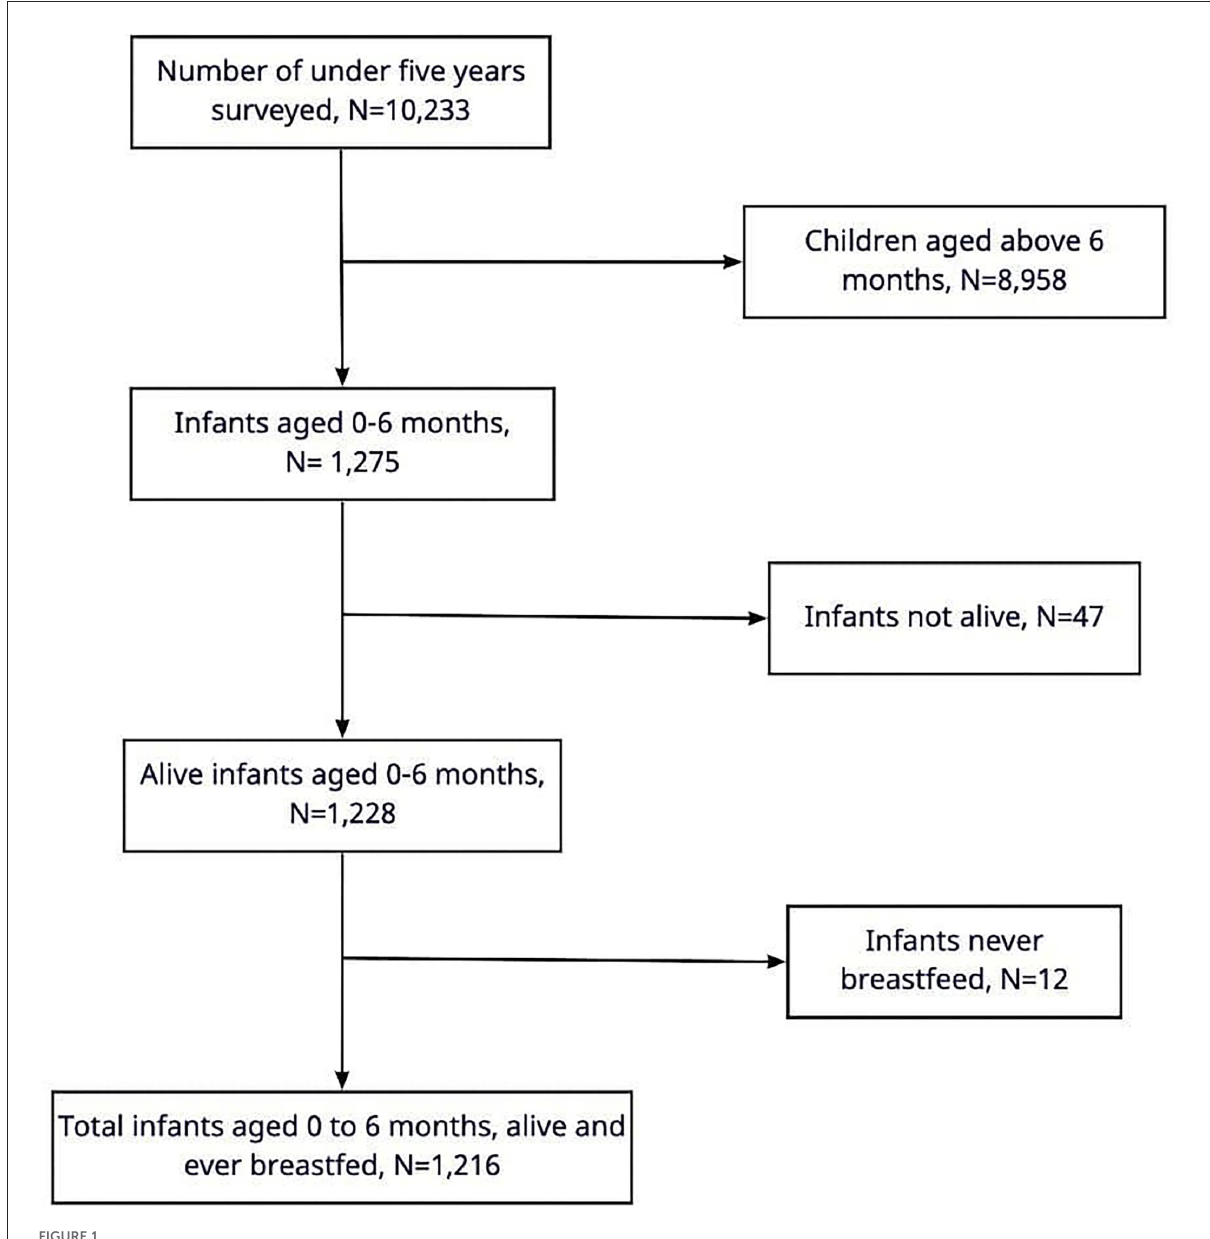
FIGURE1 Participants’